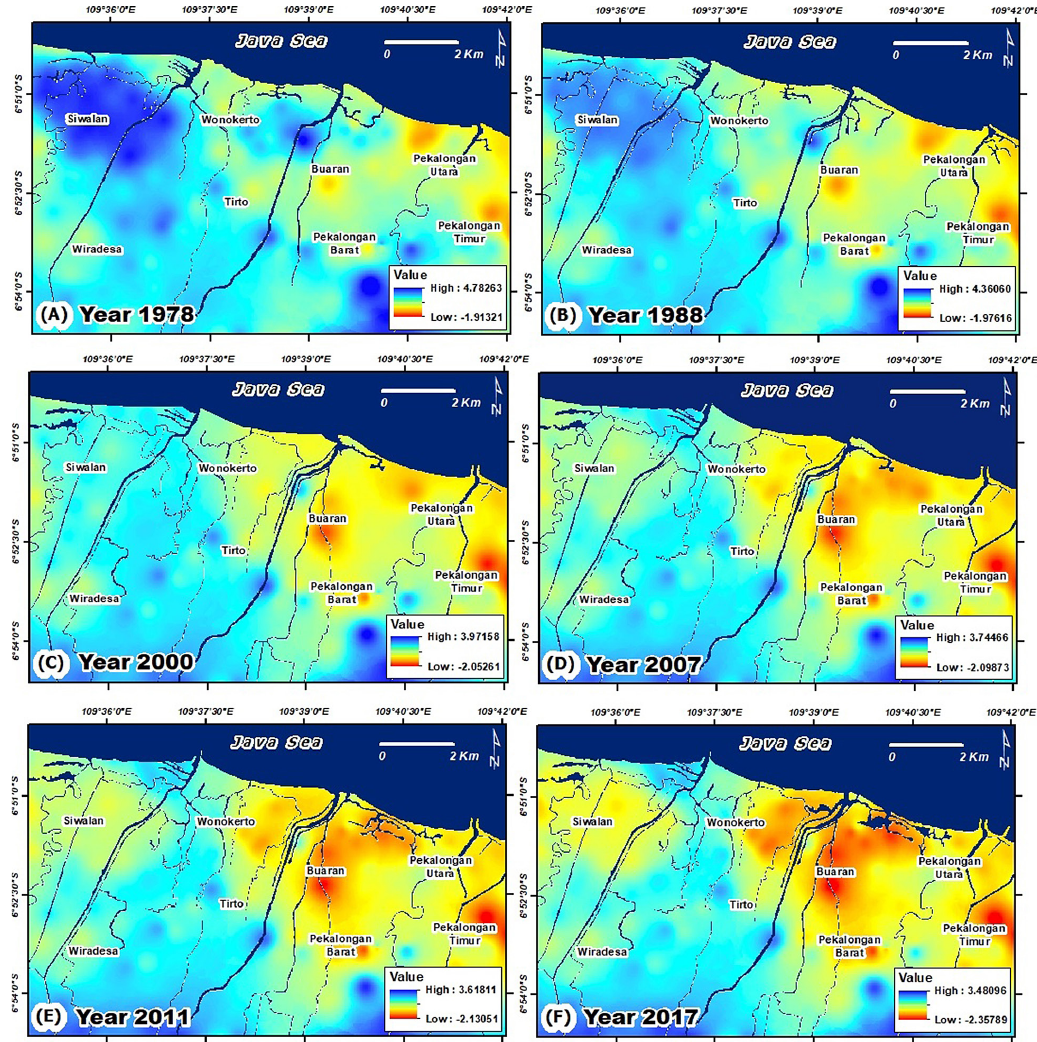
Fig. 4. The results of the dynamics of coastal topographical mapping and modelling for 1978 to 2017 in the study